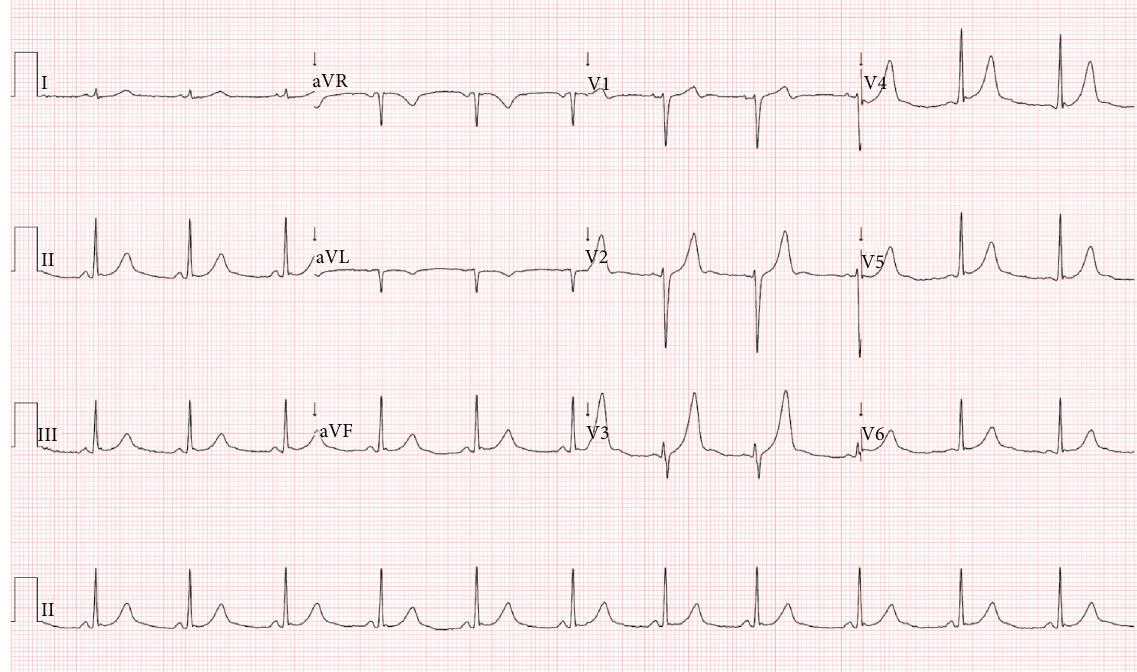
Figure 5: Twelve-lead electrocardiogram after catheter ablation. No delta waves and PR interval at the lower limit of normal but revealed peaked upright T waves in leads V3-V6 and inferior leads.